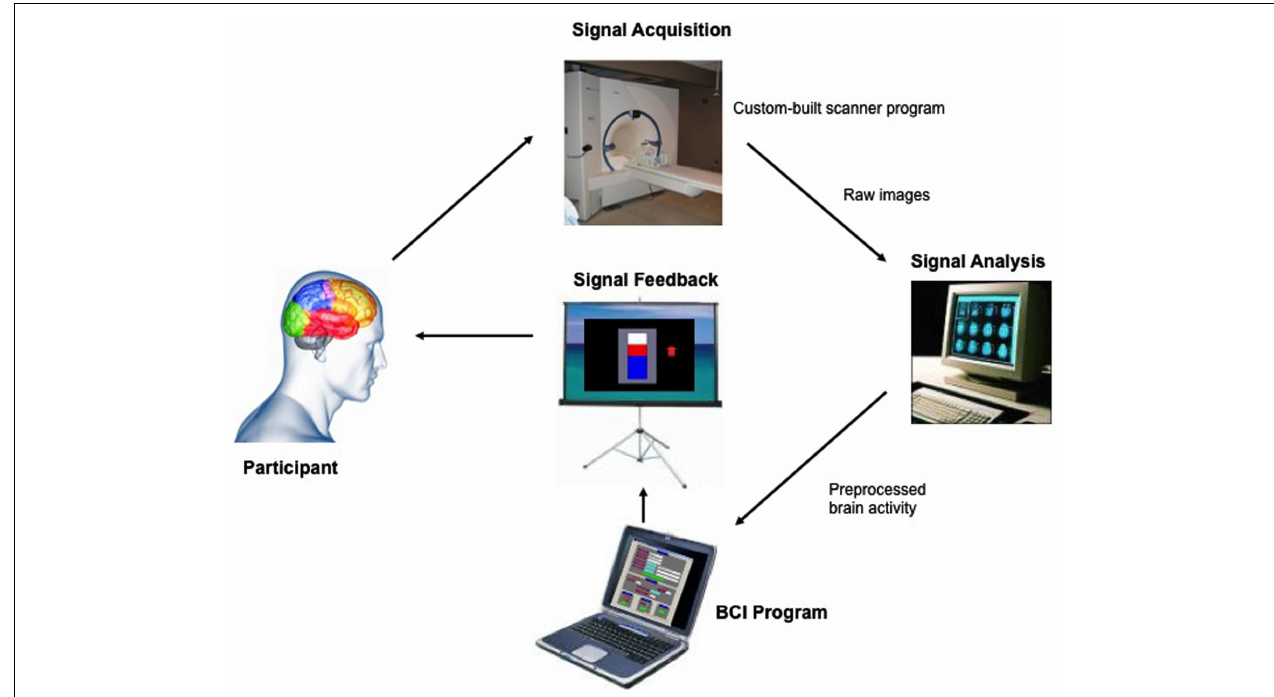
Maastricht, the Netherlands) (Goebel, 2001).The signal analysis component retrieves reconstructed images, and performs data preprocessing (including 3D motion correction) and statistical analysis.The average BOLD time-series of selected regions of interest are stored in a continuously updated file, and then exported to the custom-made visualization software which provides feedback to the subject, in real-time reproduced with permission from Sitaram et al.